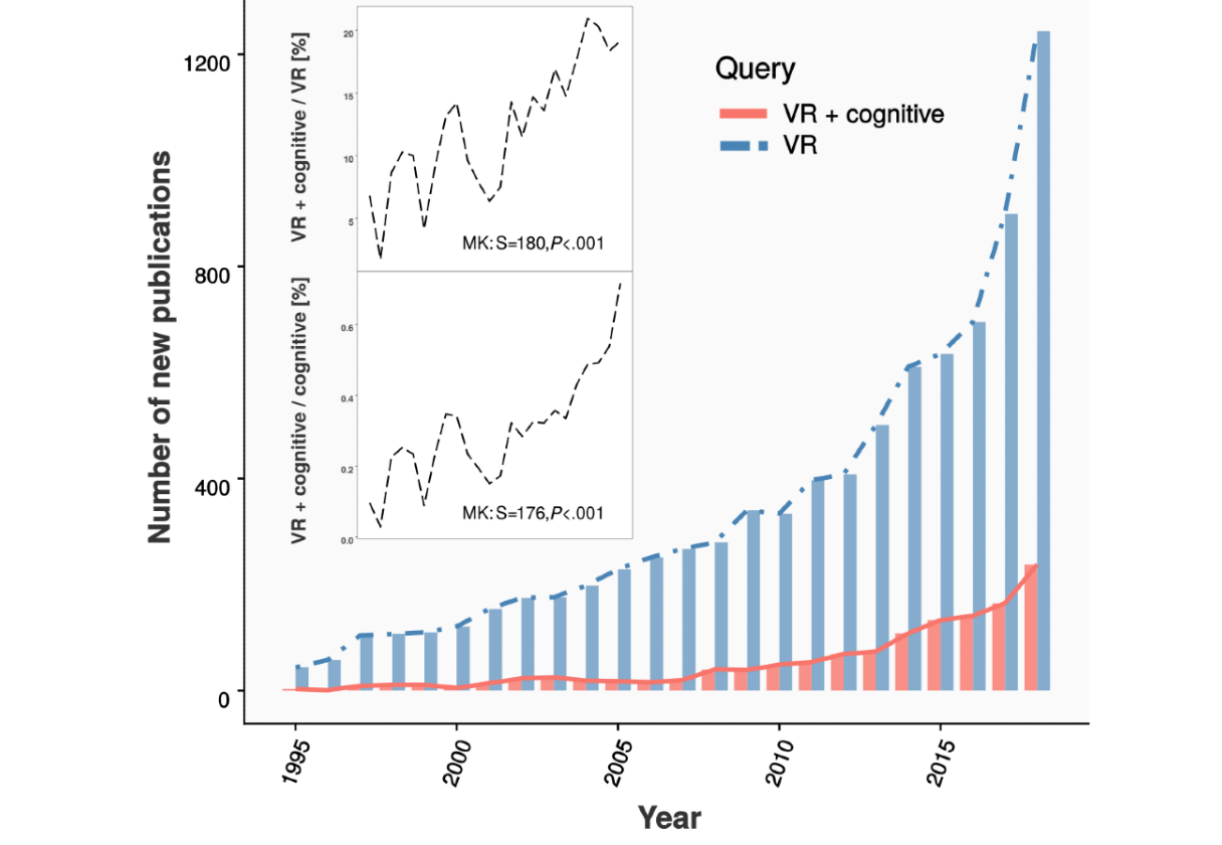
Figure 1. Temporal trends in the biomedical virtual reality literature. The PubMed database was searched for unique novel publications in the years 1995-2018 with the queries “Virtual Reality” (VR), “Virtual Reality” AND “cognitive” (VR + cognitive), and “cognitive.” Absolute new publication numbers for the former 2 queries are displayed as bars (search: September 2019). As absolute publications rose for both the VR and cognitive query, we computed the respective ratios of publication numbers over time, as shown in the inset. The proportion of annual VR + cognitive PubMed hits over all VR PubMed hits has risen to approximately 20% over the last 20 years, and nonparametric Mann-Kendall (MK) trend analysis indicates a monotonic upward trend of this proportion (S: sample estimate; positive numbers indicate upward trend). A similar temporal trend was observed for the ratio of VR + cognitive over all cognitive PubMed hits, although this proportion remains well under